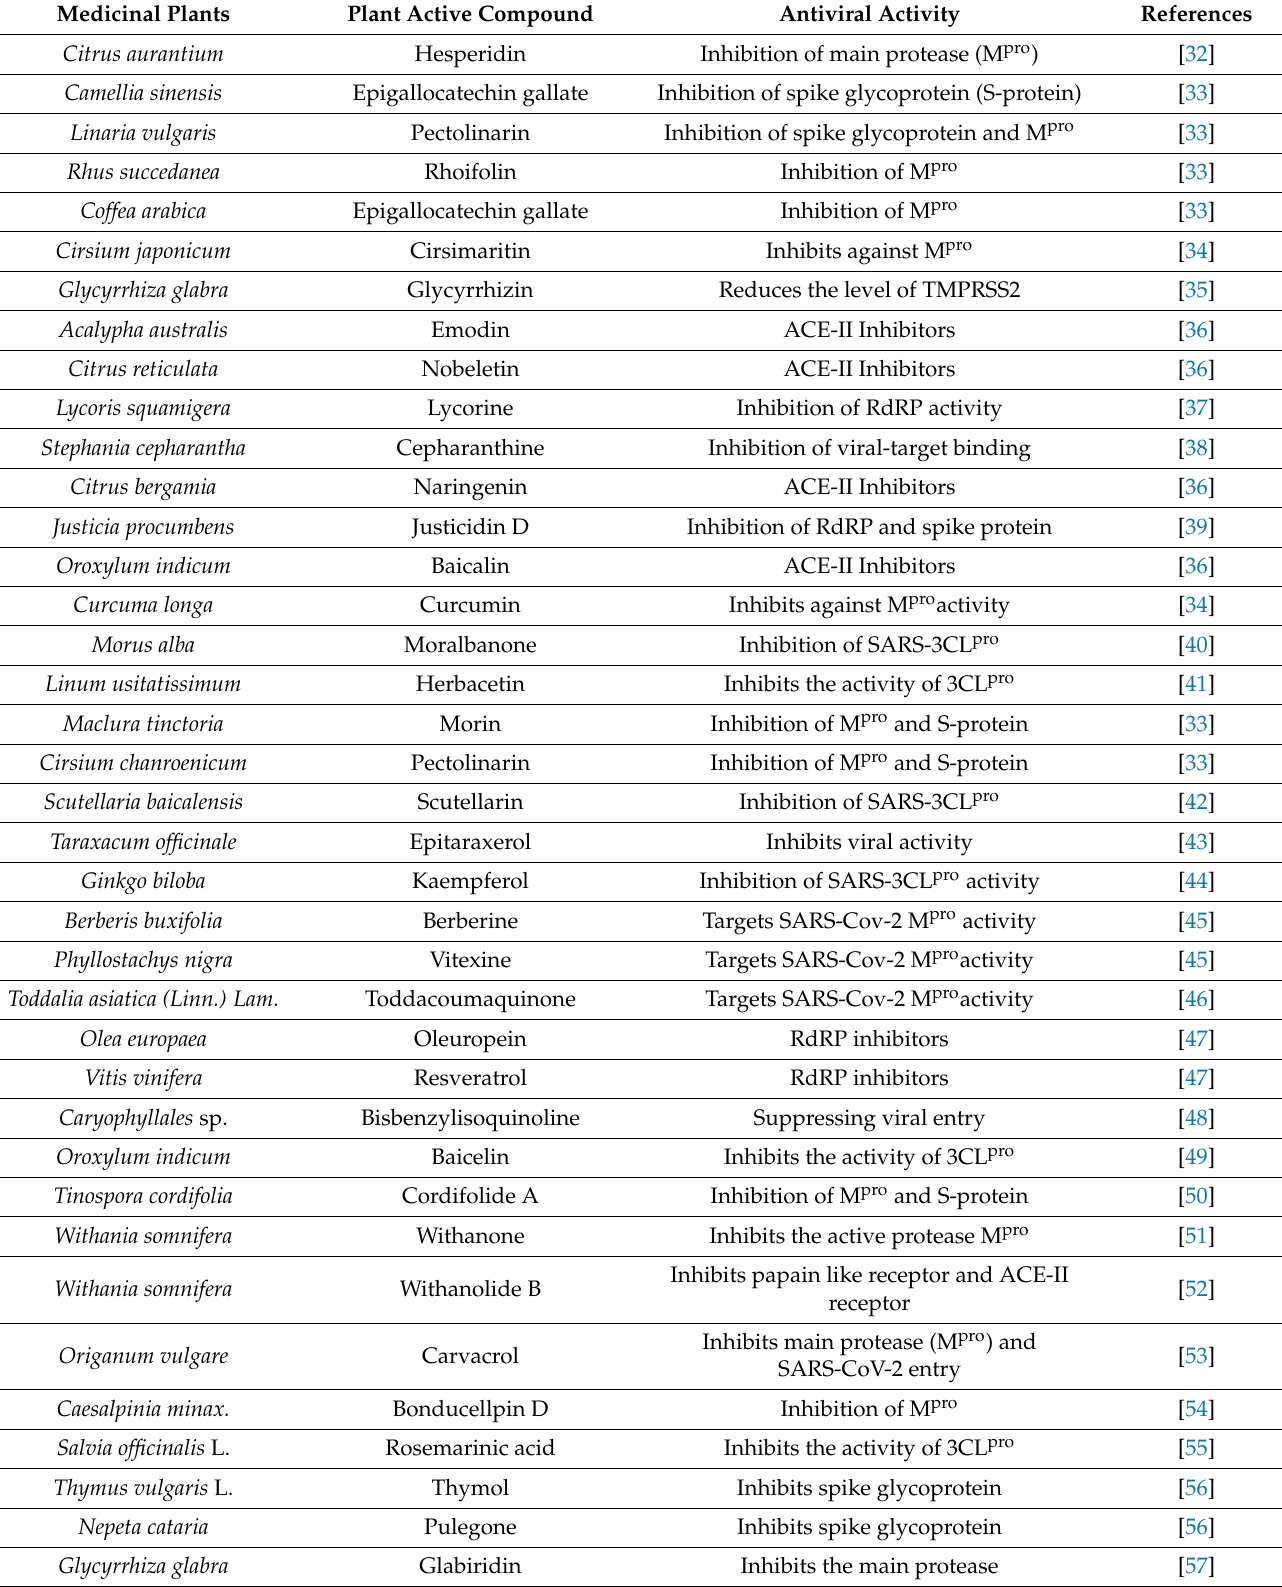
Table 1. Targeting COVID-19 associated molecules by medicinal plants and their bioactivities. Medicinal